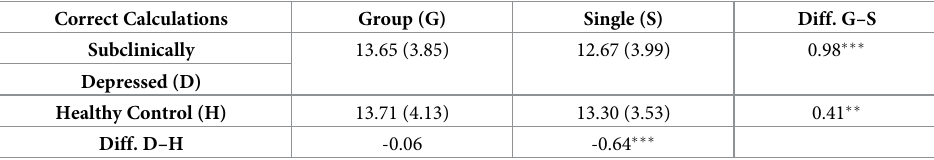
Table 6. Individual performance by